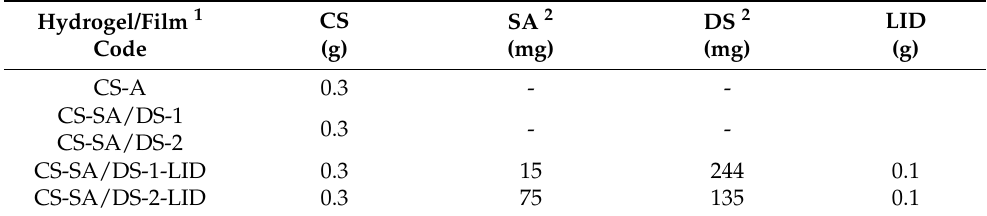
Table 1. Composition of chitosan-based